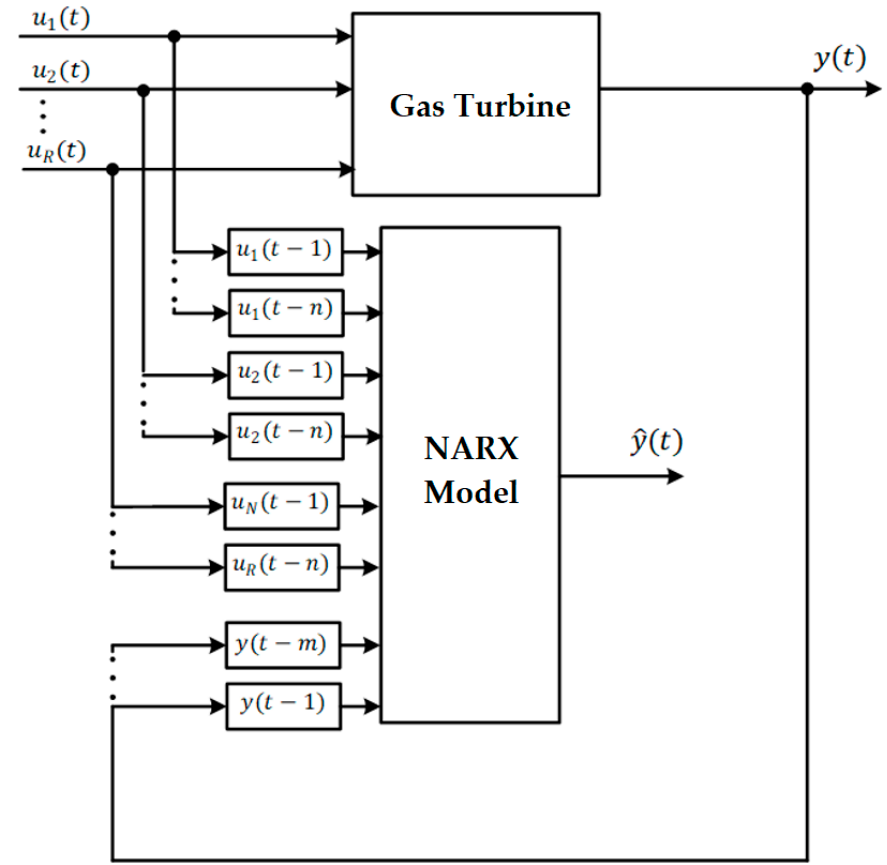
Figure 3. Structure of the NARX Serial-Parallel model for the